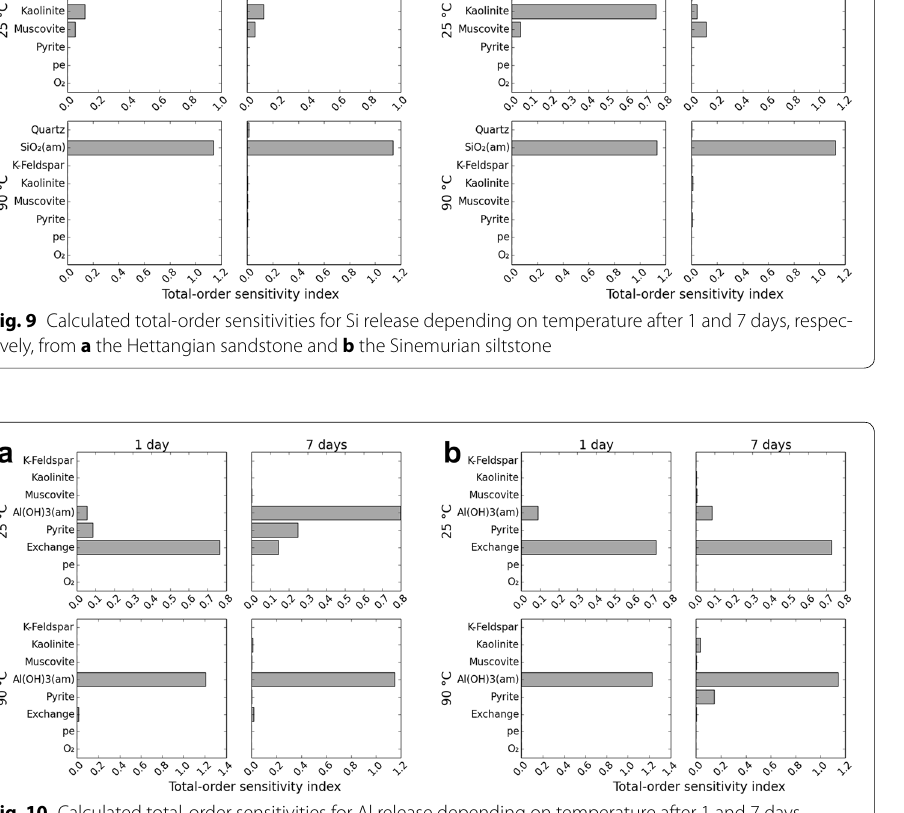
Fig. 10 Calculated total-order sensitivities for Al release depending on temperature after 1 and 7 days, respectively, from a the Hettangian sandstone and b the Sinemurian